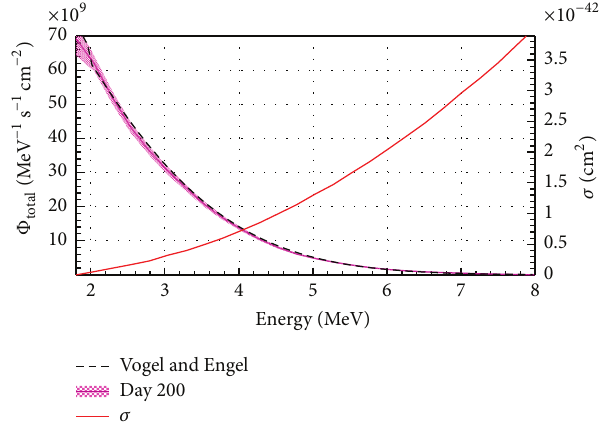
Figure 7: Total antineutrino flux per reactor at day 200 (solid curve with error band). The error includes the sum of the relative uncertainties of each of the 4 main fissile isotopes in the reactor. The dashed curve shows the parametrization suggested in [18] with the fission rates calculated by DRAGON for the LVNPP. The continuous line shows the IBD cross section as given by